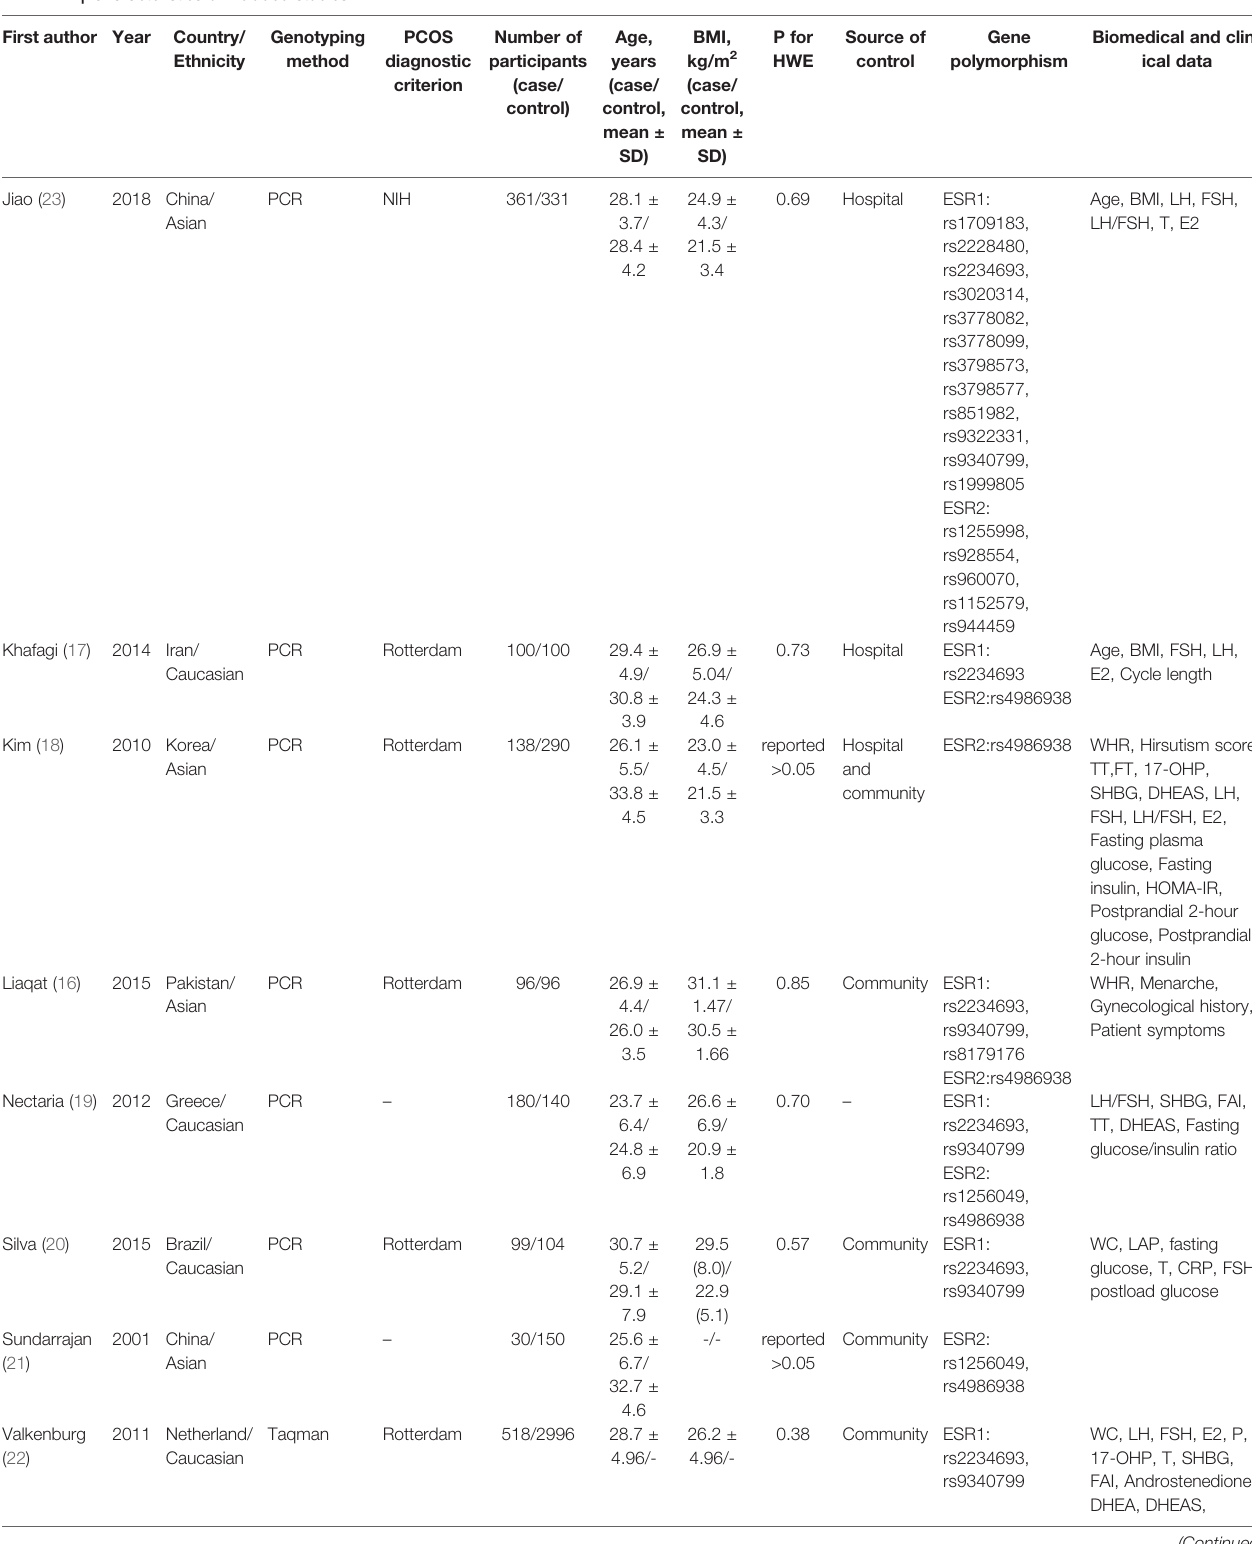
TABLE 1 | Characteristics of included